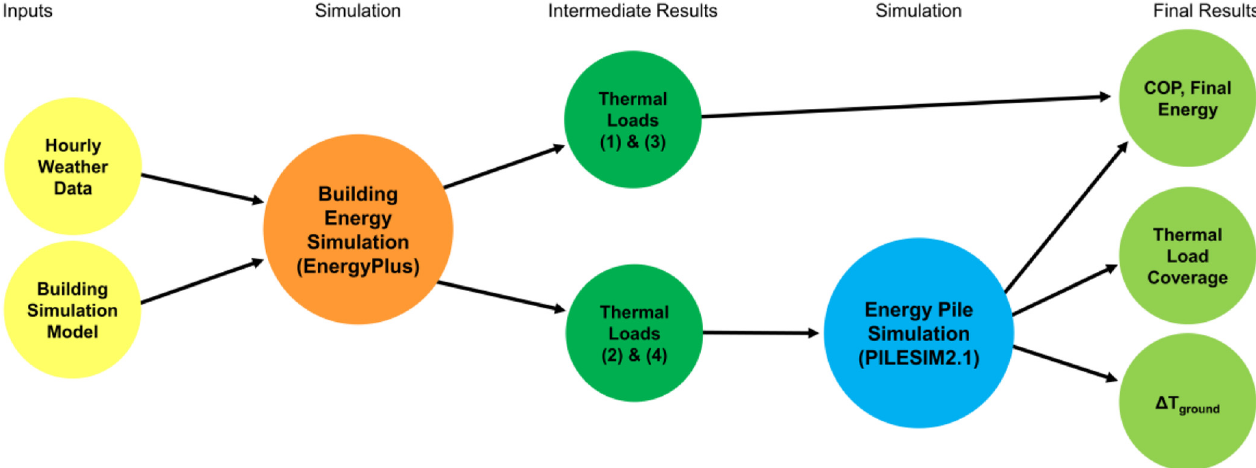
Fig. 1. Methodology diagram.